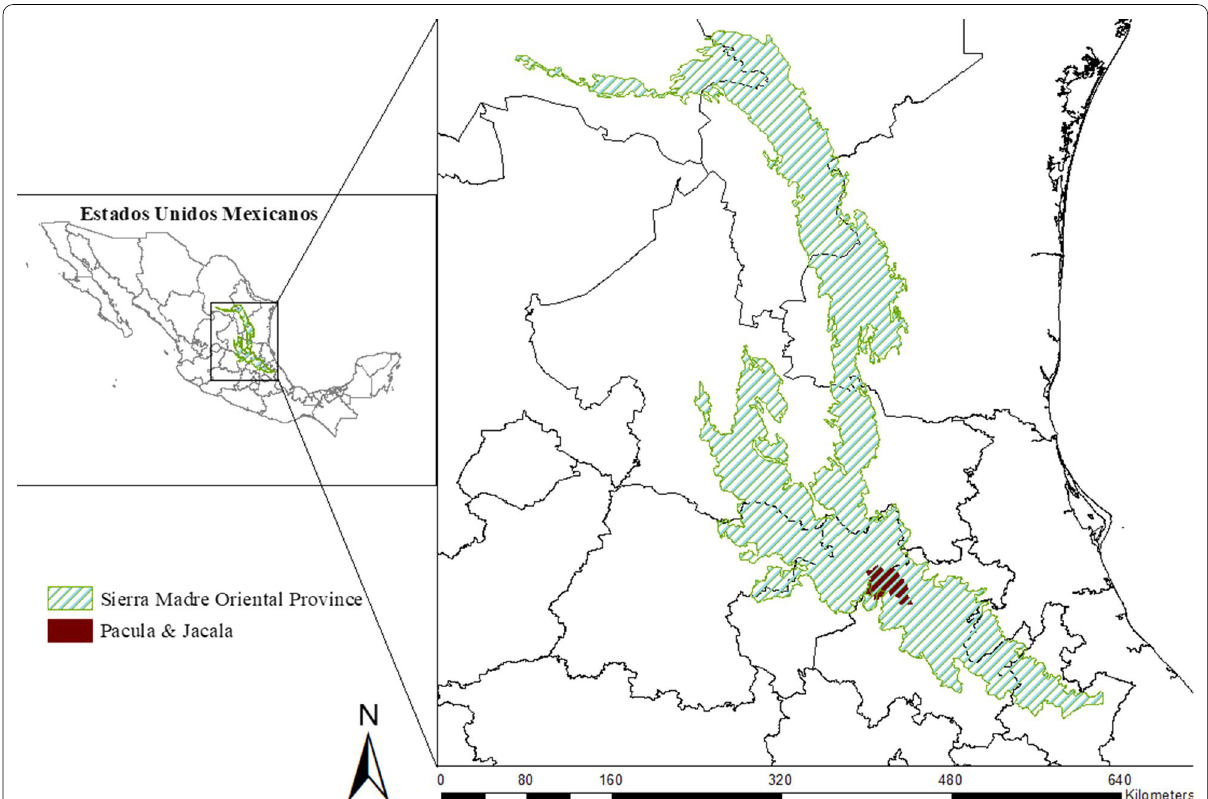
Fig. 1 Sierra Madre Oriental physiographic region, obtained from the shapefiles of Morrone et al.